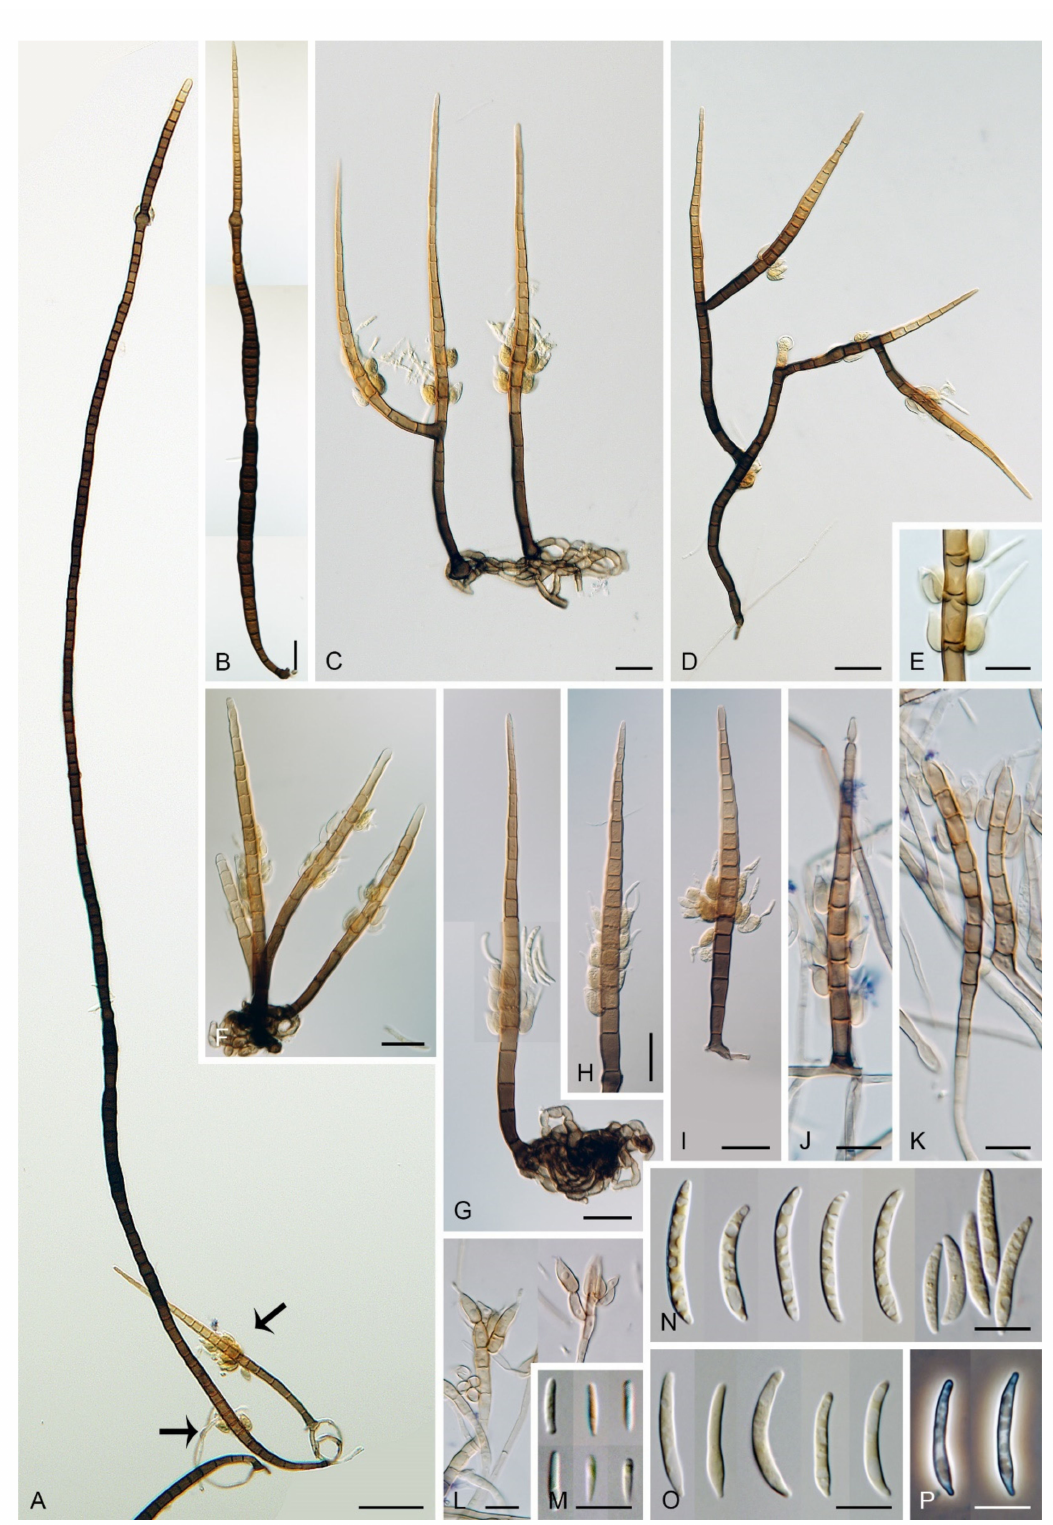
Figure 14. Zanclospora iberica . ( A ) Stanjehughesia-like and Zanclospora conidiophores (arrows indicate phialides). ( B ) Stanjehughesia-like conidiophore. ( C , D , F – I ) Zanclospora conidiophores. ( E ) Conidiogenous cells, in detail. ( J – L ) Reduced and less complex Zanclospora conidiophores. ( M ) Microconidia. ( N – P ) Macroconidia. Images: ( A – I , N – P ) on OA with U. dioica stems after 3 months; ( J – M ) on OA after 3 months; ( A – D , I , K – M , O , P ) from CBS 130426 (ex-type); ( E – H , J , N ) from CBS 130280. Bars: ( A – D , F – I ) = 20 µ m; ( J – P ) = 10 µ